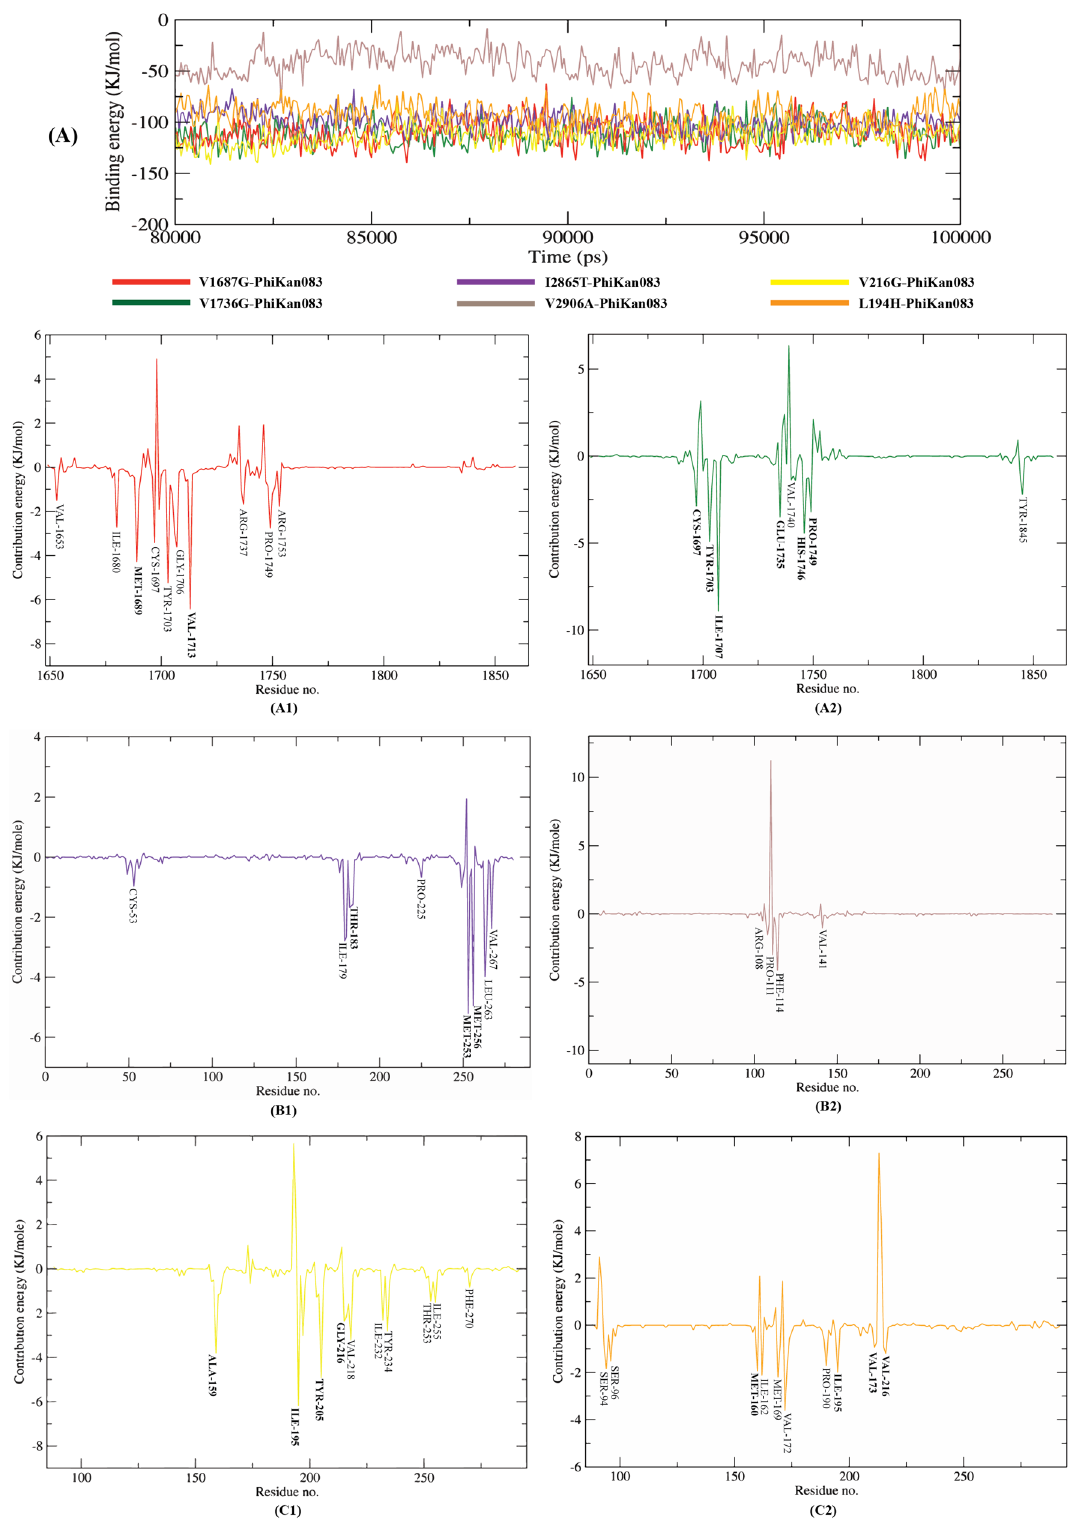
Figure 9. Graphical representation showing contribution energy plot of each residue of the six mutants, (A1) V1687G, (A2) V1736G, (B1) I183T (I2865T), (B2) V224A (V2906A), (C1) V216G and (C2) L194H. The residues that were involved in molecular docking are shown in